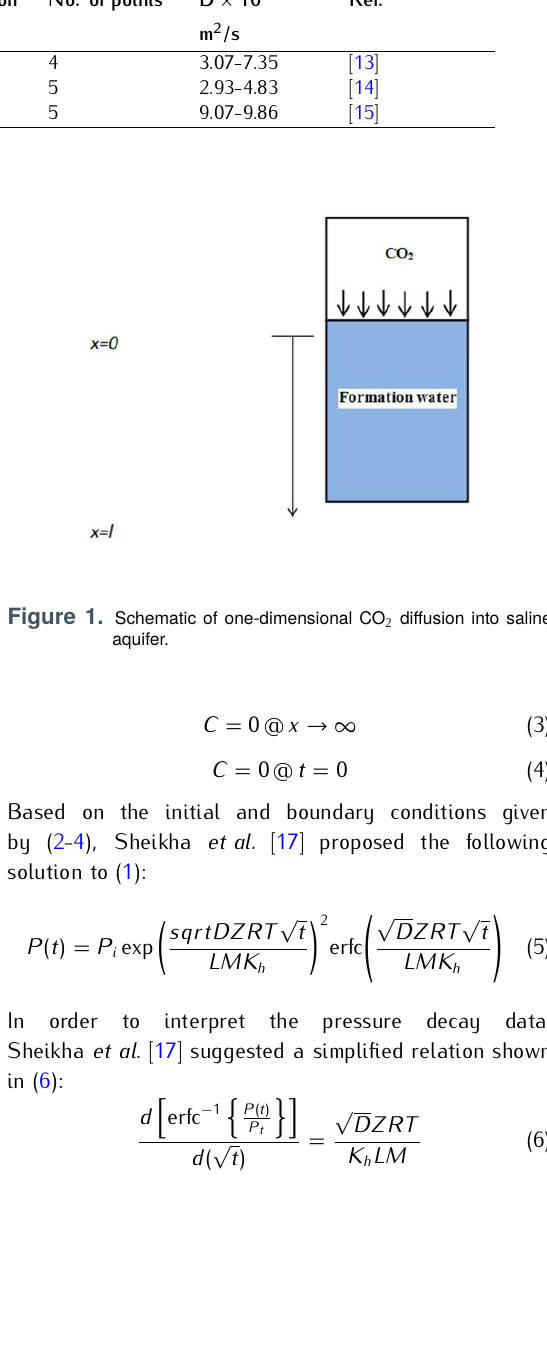
Table 2. Summary of experimental studies on CO 2 diffusivity into brine. Temperature Pressure range Salt solution Concentration